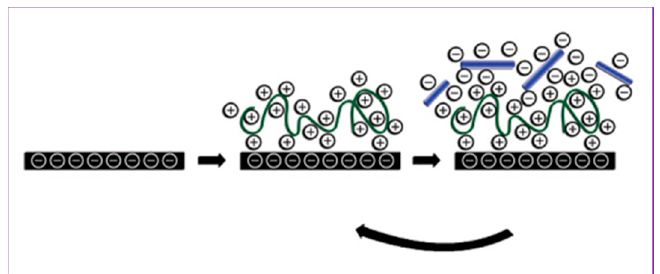
Figure 7. Schematic illustration of the build-up of electrostatically adsorbed multilayered films. Reprinted (adapted) with permission from [117], copyright (2016) American Chemical Society.